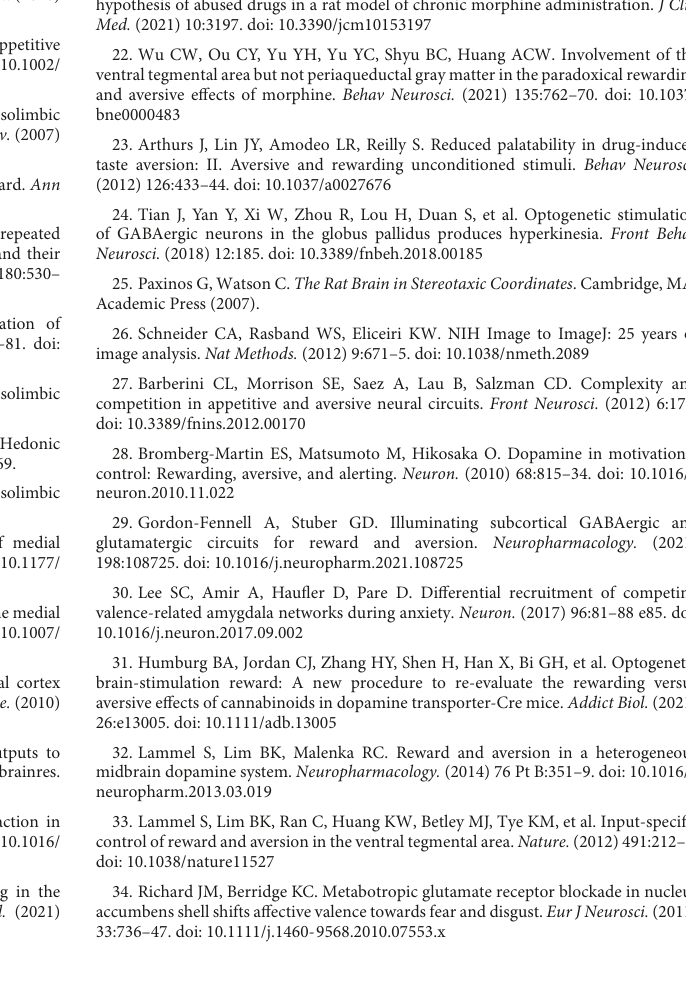
green spots indicate the IL optical stimulation location. Cg1, cingulate cortex 1; PrL, prelimbic cortex; IL, infralimbic cortex. SUPPLEMENTARYFIGURE2 Optogenetic verification of Cg1, PrL, and IL photostimulation. (A) Left: AAV virus infection with the CaMKII promotor is shown in fluorescent green, c-Fos expression is shown in red; merged CaMKII and c-Fos expression is shown in the Cg1, PrL, and IL. Middle: brain atlas depicting locations of optical stimulation in the Cg1, PrL, and IL. (B) c-Fos expression (%) following optical stimulation of the Cg1, PrL, and IL between the EYFP and ChR2 groups. (C) The location of the buried optical fibers in the EYFP and ChR2 groups during the conditioning and extinction phases. Blue spots depict Cg1 optical stimulation location, orange spots depict PrL optical stimulation location, and green spots depict IL optical stimulation location in the EYFP group during conditioning and extinction. Gray spots depict Cg1 optical stimulation location, brown spots depict PrL optical stimulation location, and dark green spots depict IL optical stimulation location in the ChR2 group during conditioning and extinction. Cg1, cingulate cortex 1; PrL, prelimbic cortex; IL, infralimbic